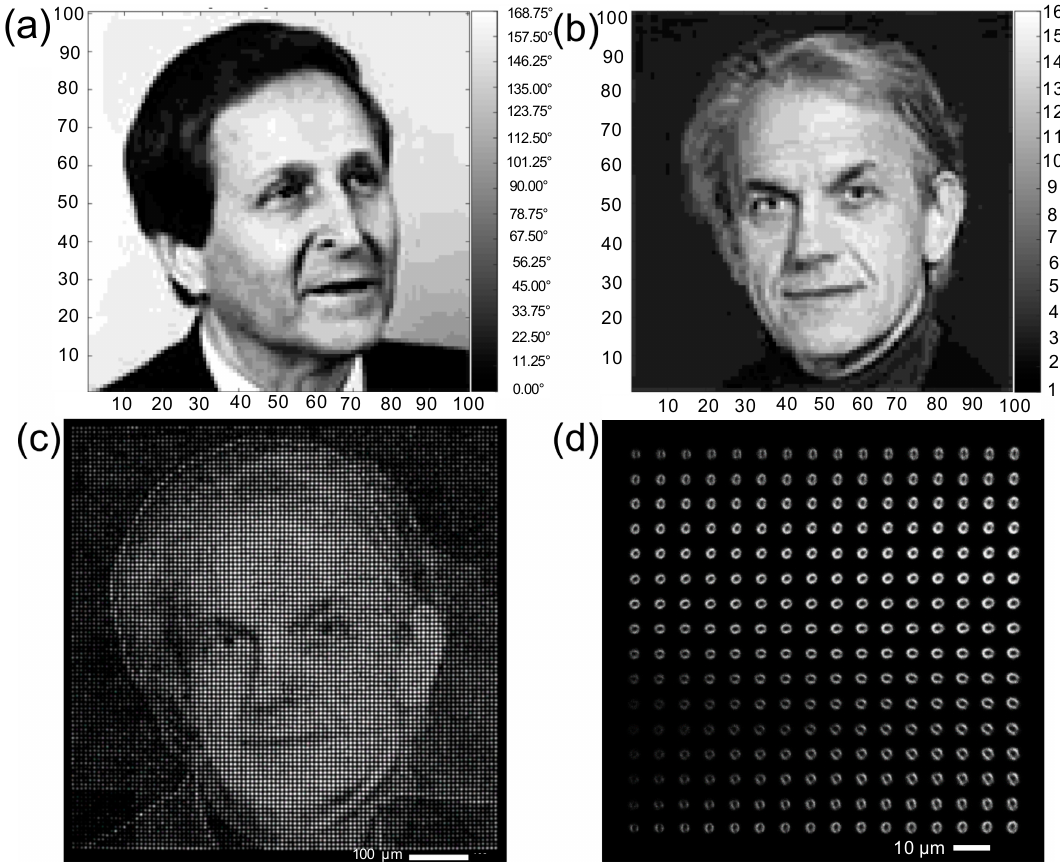
Figure 3. ( a , b ) are the encoded images of two Nobel laureates in 16 orientation levels and 16 intensity levels, respectively. ( c ) 100 × 100 entangled patterns among 16 × 16 intensity and orientation levels. ( d ) The fluorescence calibration matrix was fabricated for decoding (fluorescence excitation at 405 nm).